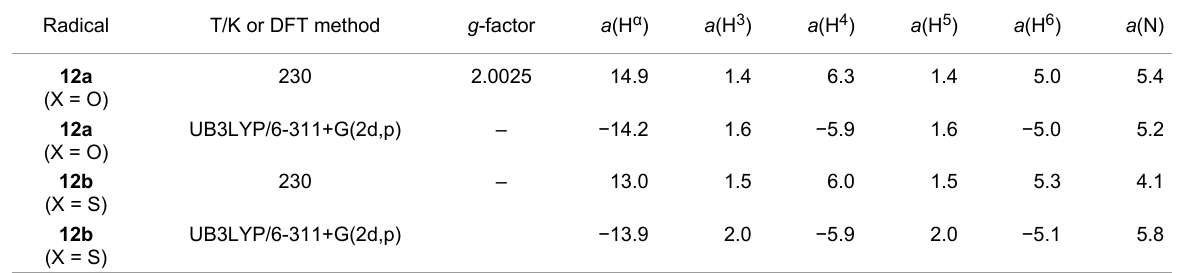
Table 2: EPR parameters of spiro - benzyl radicals 12 derived from 2a,b a .